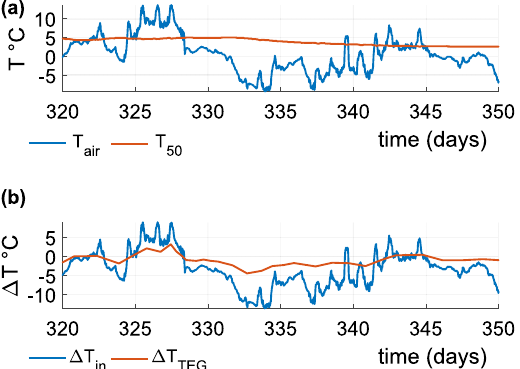
Figure 13. ( a ) Air and soil temperatures at a depth of 50 cm during winter. Air temperature differs from the soil temperature and creates a stable temperature difference; ( b ) temperature difference at the sensor input and temperature difference on the